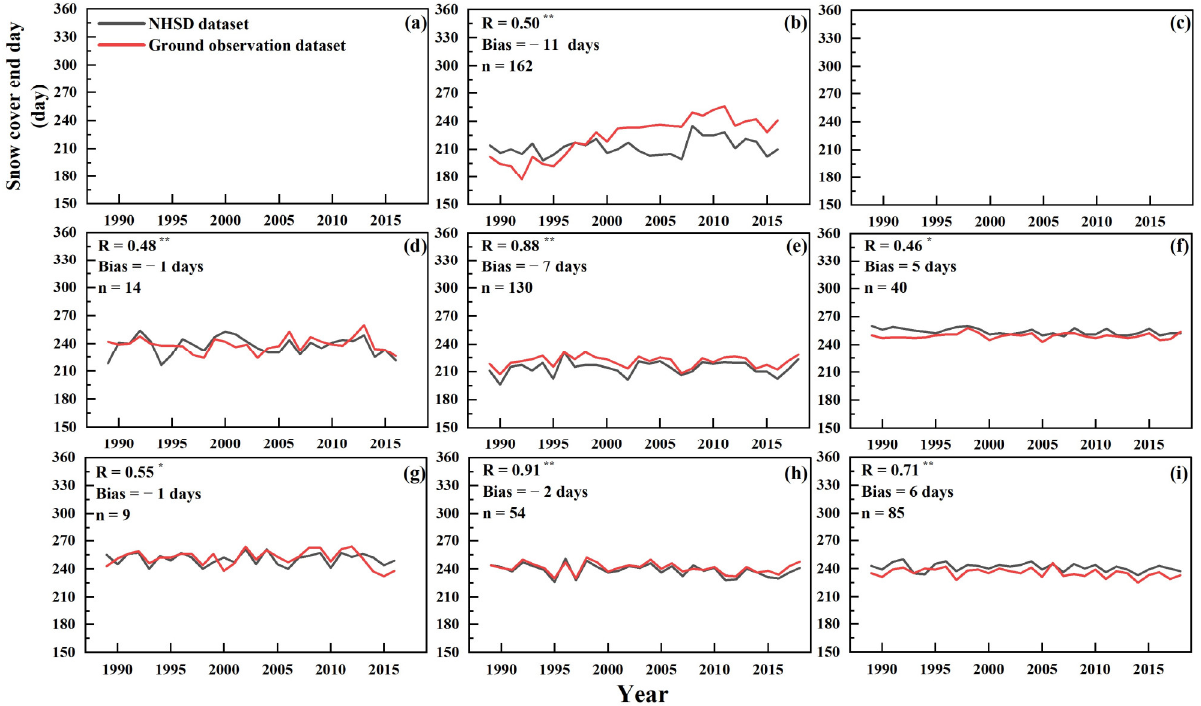
Figure 11. Comparison of the SCED derived from NHSD and ground observation datasets in typical areas. The typical areas are ( a ) the Alps, ( b ) the Rocky Mountains, ( c ) the Qinghai–Tibet Plateau, ( d ) Alaska, ( e ) the Eastern European Plain, ( f ) the Eastern Siberian Mountains, ( g ) Northern Canada, ( h ) the West Siberian Plain, and ( i ) the Central Siberian Plateau. The vertical axis labels in panels ( b – i ) are the same as those in panel ( a ). * and ** indicate that the correlation were significant at the 95% and 99% confidence level, respectively.